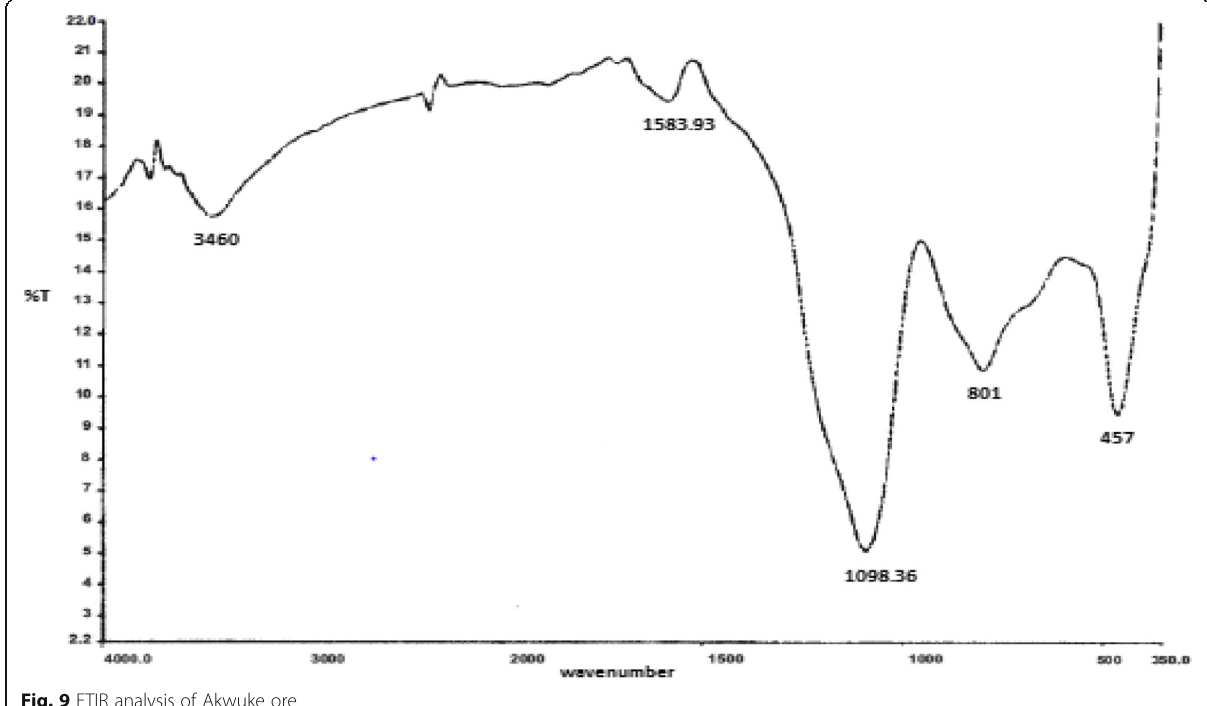
Fig. 9 FTIR analysis of Akwuke ore